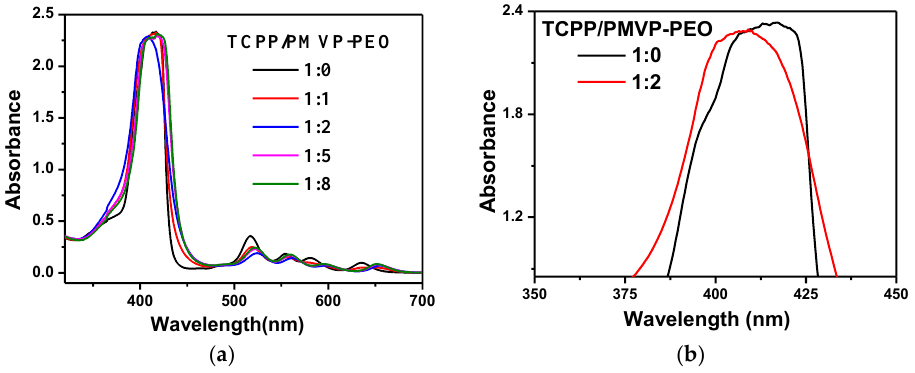
Figure 4. ( a ) UV-vis absorption spectra of TCPP (black line) and TCPP/PMVP-PEO with different charge ratios of 1:0 (black line), 1:1 (red line), 1:2 (blue line), 1:5 (pink line) and 1:8 (green line), respectively; ( b ) Magnified absorption spectra of TCPP and TCPP/PMVP-PEO at the charge ratio of 1:2. [TCPP] = 0.02 mM, pH = 10.0. PMVP-PEO is the abbreviation of PMVP 41 -b -PEO 205 .